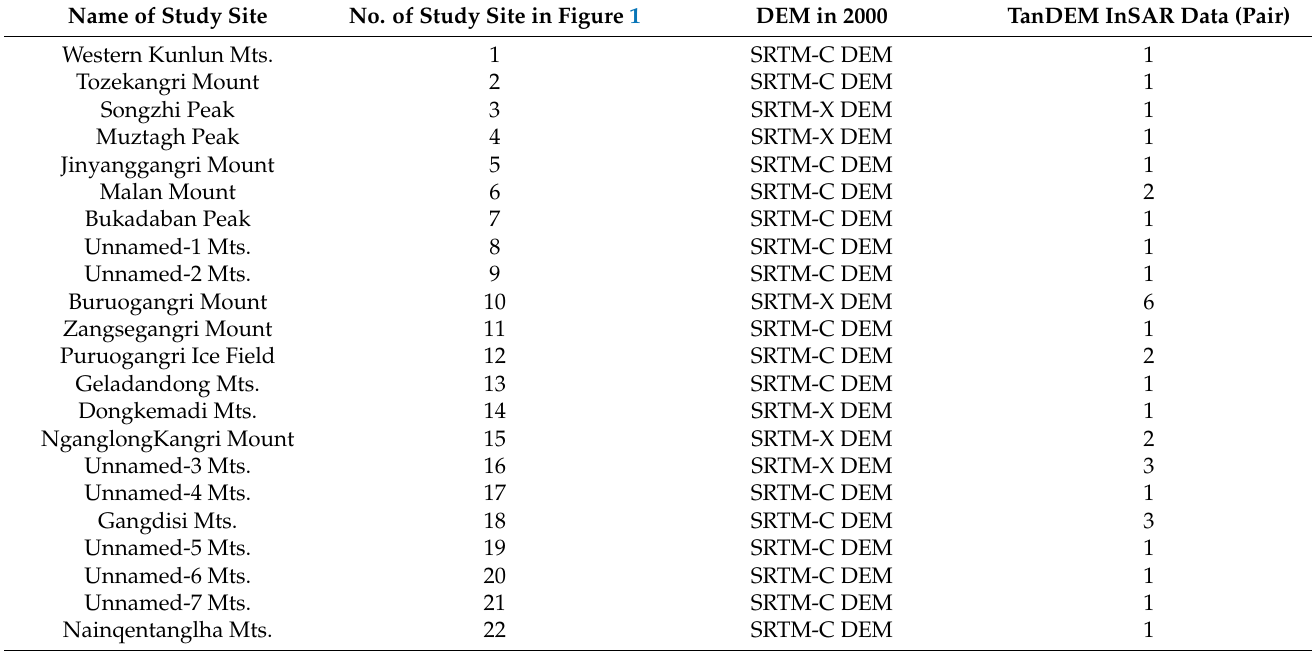
Table 1. The used SRTM DEM and TanDEM-X bistatic InSAR data in this